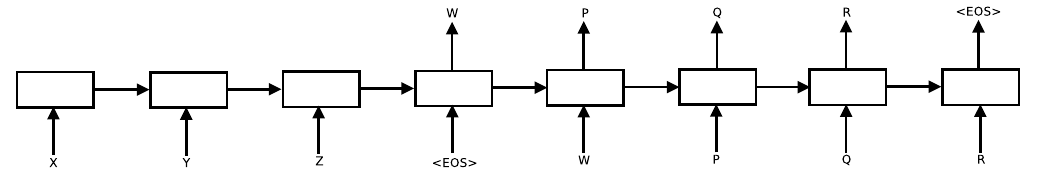
Figure 1. “XYZ” is the input sequence and “PQR” is the output sequence [58].